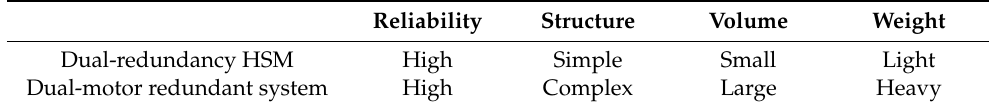
Table 5. Contrast with dual-motor redundant system.